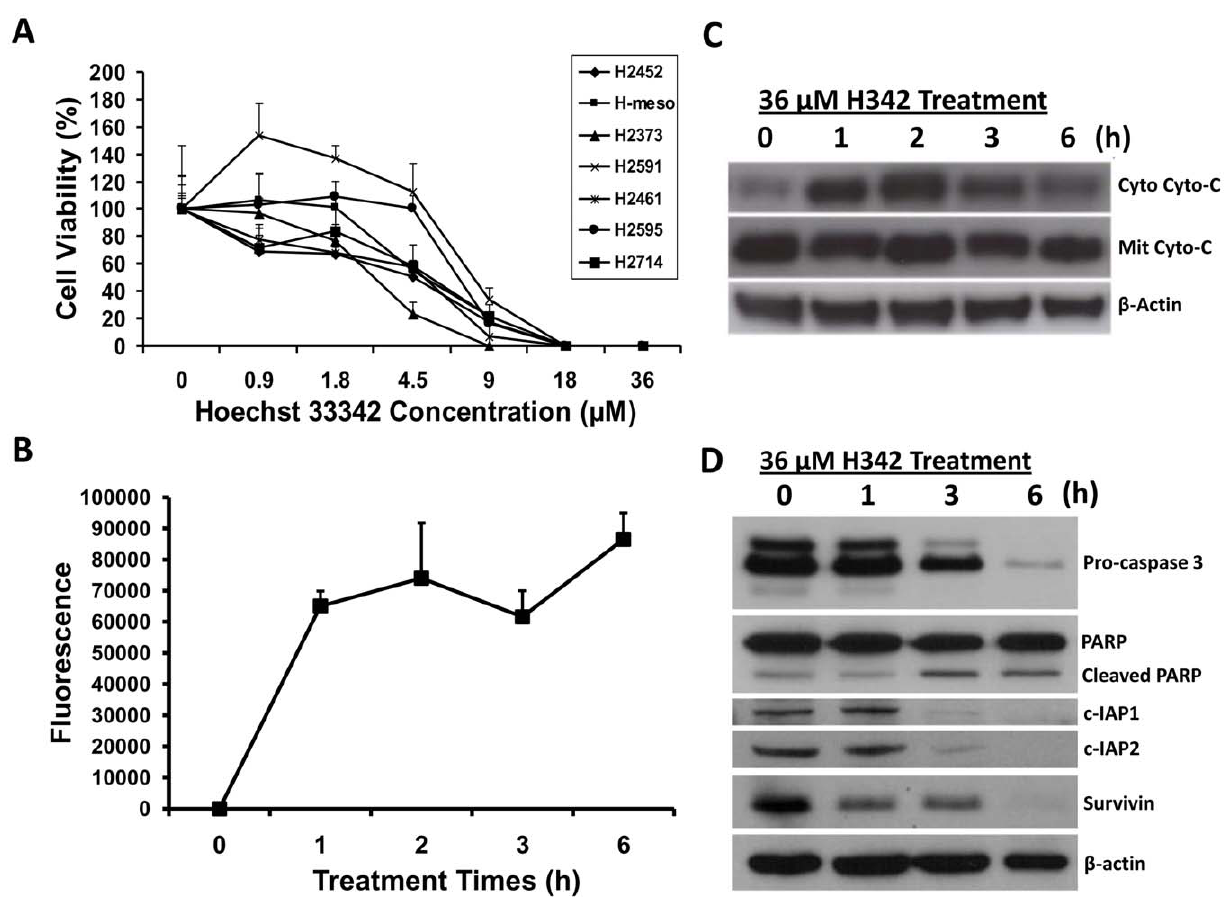
Figure 1. Effect of H342 on cell viability, caspase 3 activity, cytochrome c translocation, and apoptosis-associated protein levels. A, Effect of H342 on cell viability of 7 human mesothelioma cell lines. 7 mesothelioma cell lines were treated with different concentrations of H342 (0– 36 m M) for 24 hours. Cell viability was determined by MTT assay. Line chart represents the cell viability (%) with mean + SE. B, Measurement of endogenous caspase 3 activity after 36 m M H342 for different times in H2373 cells. Line chart indicates relative fluorescence units with mean + SE. C, Determination of cytochrome c translocation induced by 36 m M H342 for different times in H2373 cells. After treatment, the cytosolic and the mitochondrial fractions were isolated by differential centrifugation. Levels of cytochrome c in cytosolic and the mitochondrial fractions were determined by immunoblotting. D, Protein levels of poly (ADP-ribose) polymerase (PARP), inhibitor of apoptosis protein 1 and 2 (c-IAP1 and 2), and caspase 3 were determined by immunoblotting after H2373 cells were treated with 36 m M H342 for different